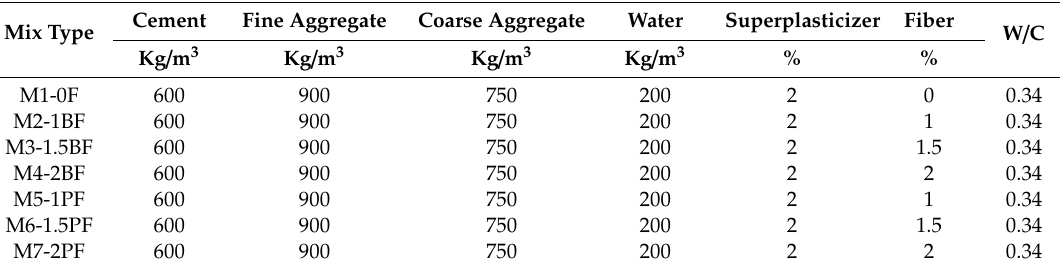
Table 2. Concrete Mix Design Details.